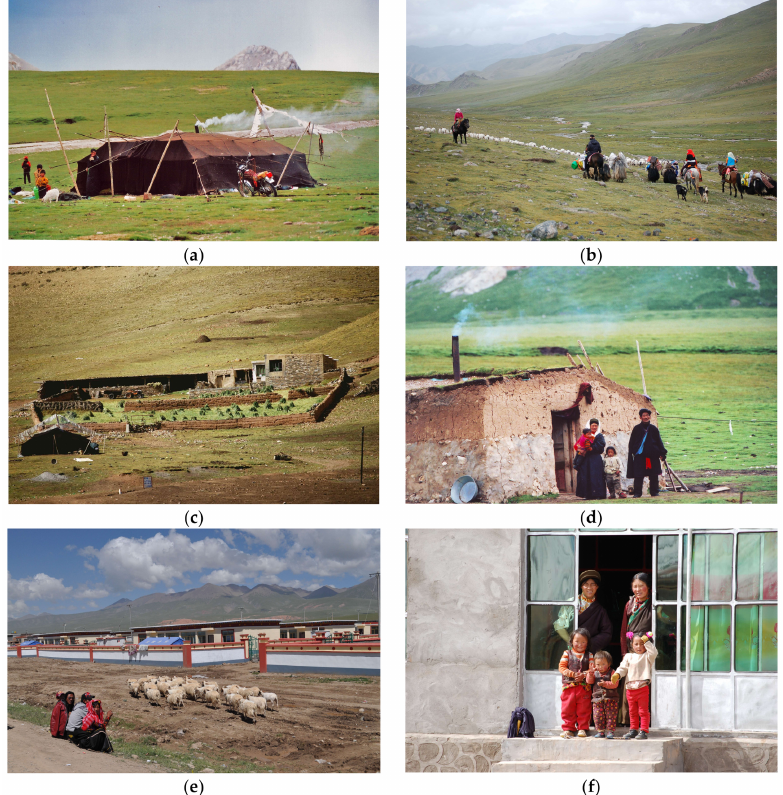
Figure 5. The last two decades have seen major changes in pastoral practices and people’s livelihoods in the Sanjiangyuan region, shifting from traditional nomadic pastoralism on the vast grasslands up until the 1990s and early 2000s; to sedentarization, with construction of winter homes and introduction of agricultural practices (mostly for winter fodder) in the mid-2000s; to full relocation and settlement of a large portion of the population in new villages built under the eco-migration policy. Photo descriptions: ( a ) Tibetan family and yak hair tent on the grasslands; ( b ) pastoralist family moving to summer pastures; ( c ) winter dwelling of a Tibetan pastoralist family, including winter home, livestock shelter, and agricultural field; ( d ) family living in converted livestock shelter; ( e ) “nomads without pastures” in a recently built relocation village; ( f ) Tibetan “nomad” family, formerly livestock herders, now living in a relocation